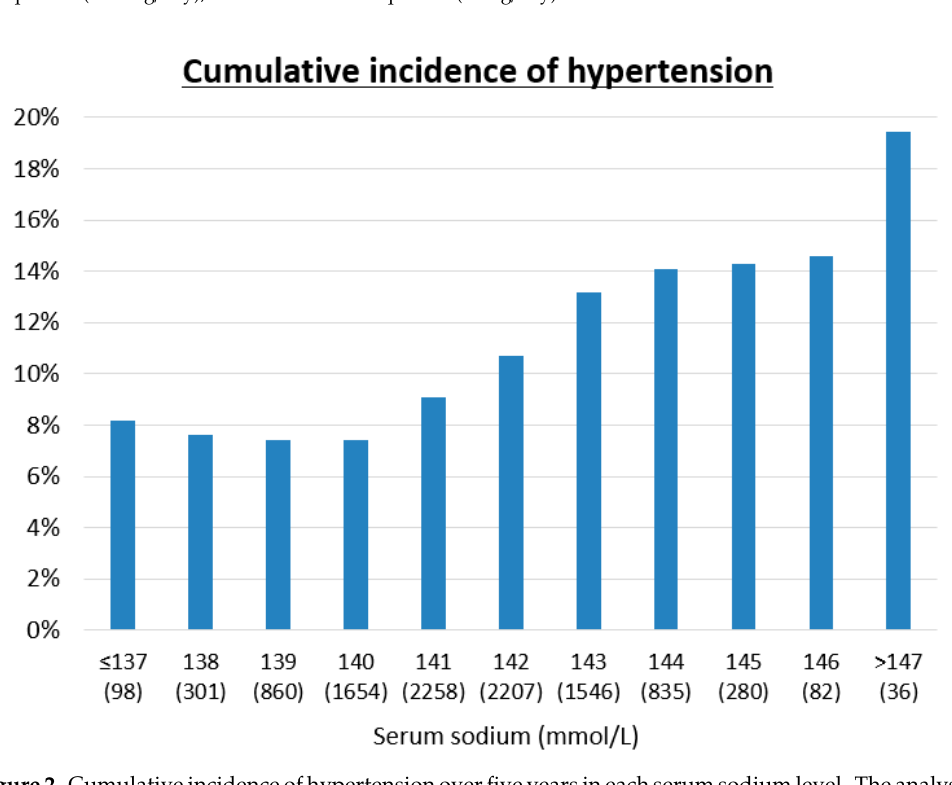
Figure 2. Cumulative incidence of hypertension over five years in each serum sodium level. The analysis among each serum sodium was conducted by Mantel-Haenszel test for trend ( p =